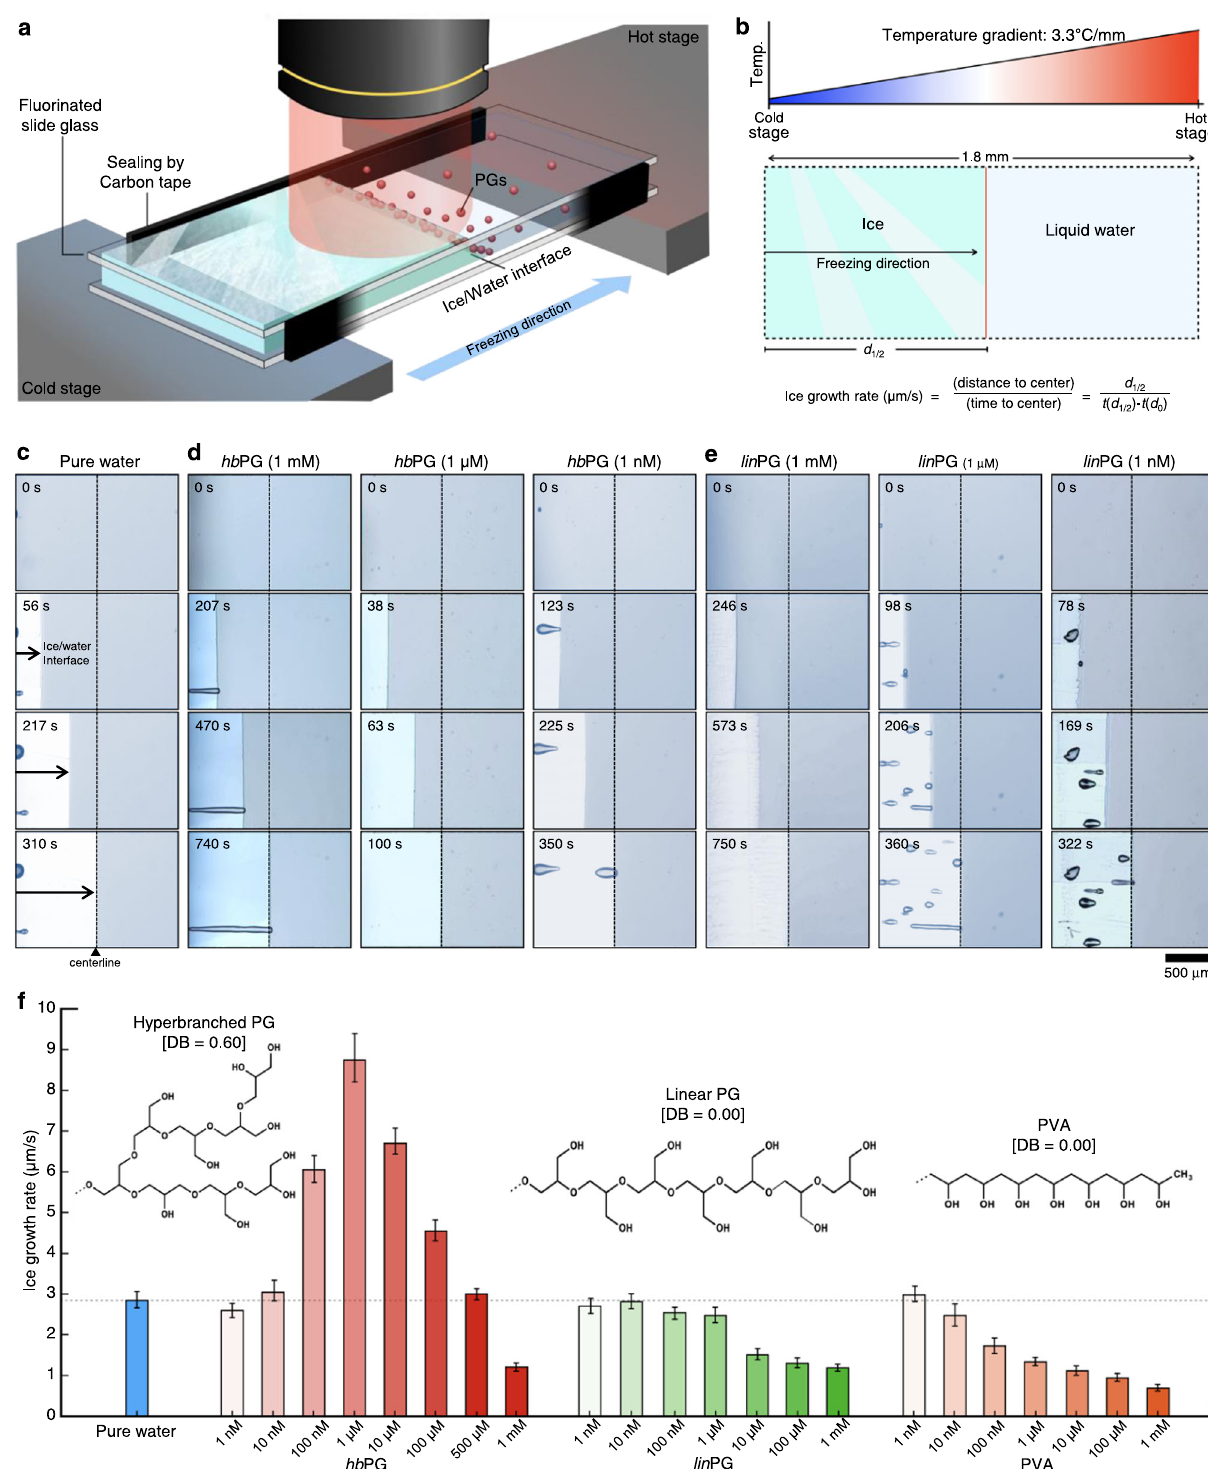
Fig. 1 | Evaluation of the effect of PGs on ice growth. a Schematic of the instru- ment for one-directional freezing experiments. b Temperature gradient according to the freezing coordinate and quanti fi cation of ice-growth rate. c , d , e Polarized optical and fl uorescence microscopic images for the movement of the ice/water interface with respectto time in ( c ) pure water, ( d ) hb PG, and ( e ) lin PG. The status